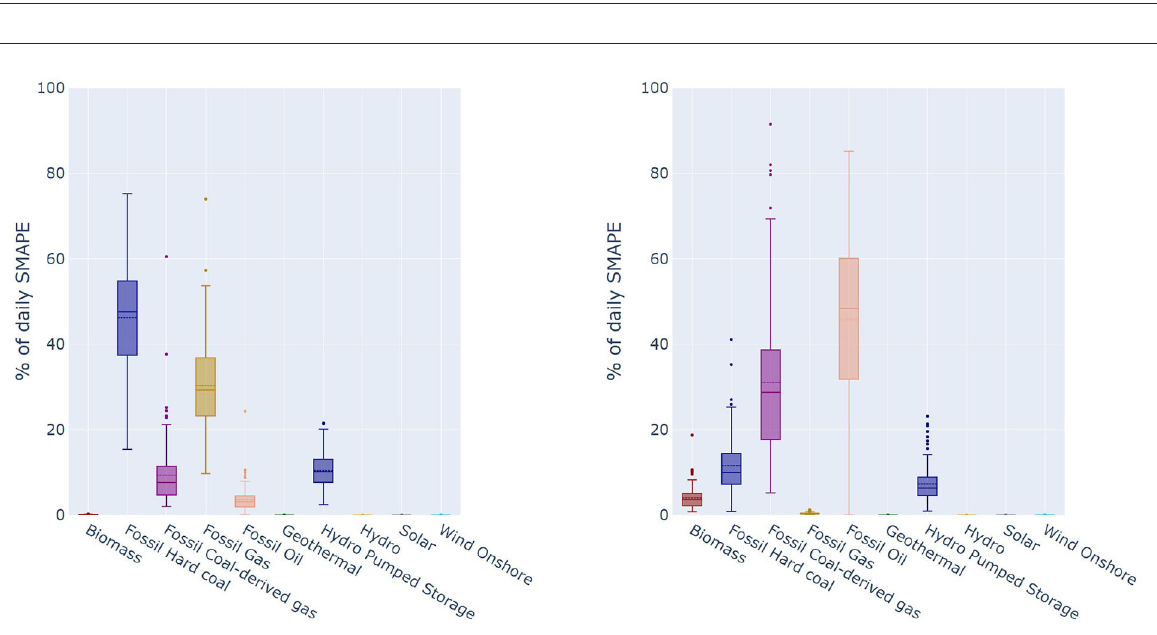
FIGURE6 Box plots representing the relative importance (RI) of the different technologies toward the daily SMAPE of the NN64 ETMF model. On the left, the Climate change total category and on the right the Respiratory effects, inorganics category. The continuous line at the center of each boxplot is the median of the distribution, while the dotted line is the